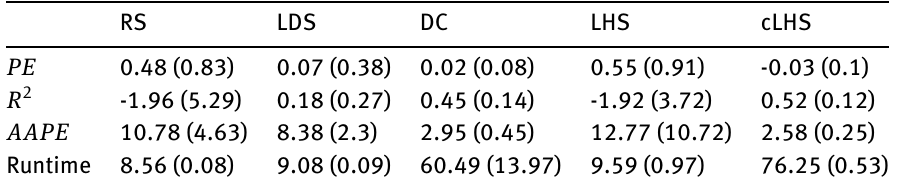
Table 2: Average accuracy and speed (in seconds) of the experimental design methods over 10 runs when s = 220 . The num- bers in parentheses are the corresponding standard deviations.